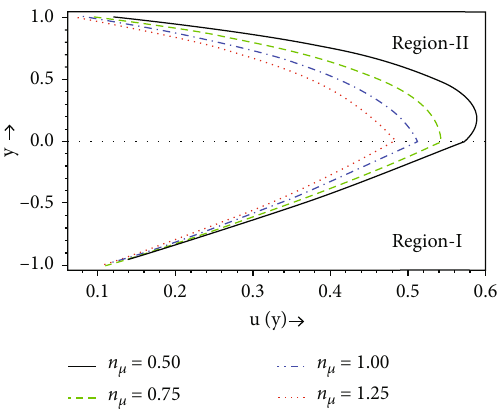
= μ / μ μ 2 1 on velocity